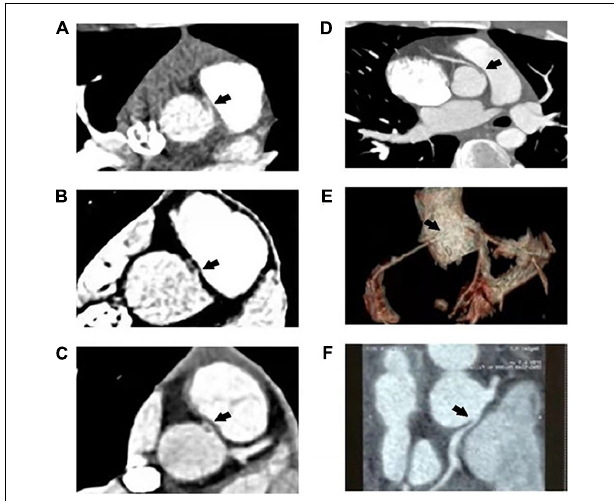
FIGURE 2 | Computed tomography angiography (CTA) of six patients. Black arrows indicate the interarterial course between the aorta and pulmonary artery. (A) Interarterial R-ACAOS with no obvious stenosis (Patient 1). (B) Interarterial R-ACAOS with proximal RCA stenosis (Patient 2). (C) Interarterial R-ACAOS with no obvious stenosis (Patient 4). (D) Interarterial R-ACAOS with proximal RCA stenosis (Patient 6). (E) Interarterial R-ACAOS with proximal RCA stenosis (Patient 7). (F) Interarterial L-ACAOS with proximal LCA stenosis (Patient 8).